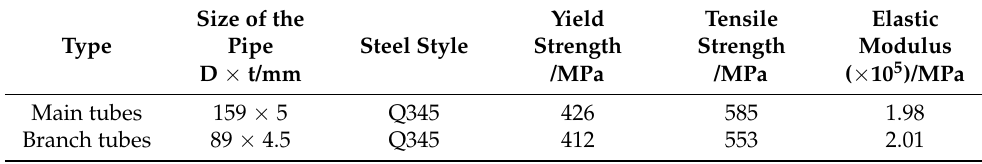
Table 3. Mechanical properties of the steel